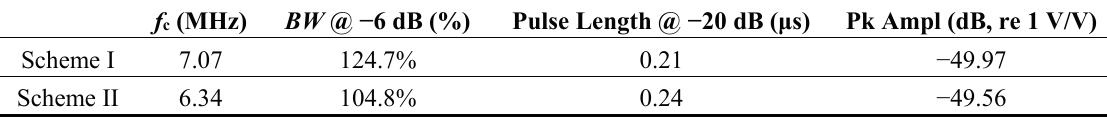
Figure 3. The simulated waveforms and frequency spectra of the designed TOFD ultrasonic transducers with ( a ) scheme I; ( b ) scheme II. Table 3. Simulation results of the designed TOFD ultrasonic transducers with scheme I and scheme